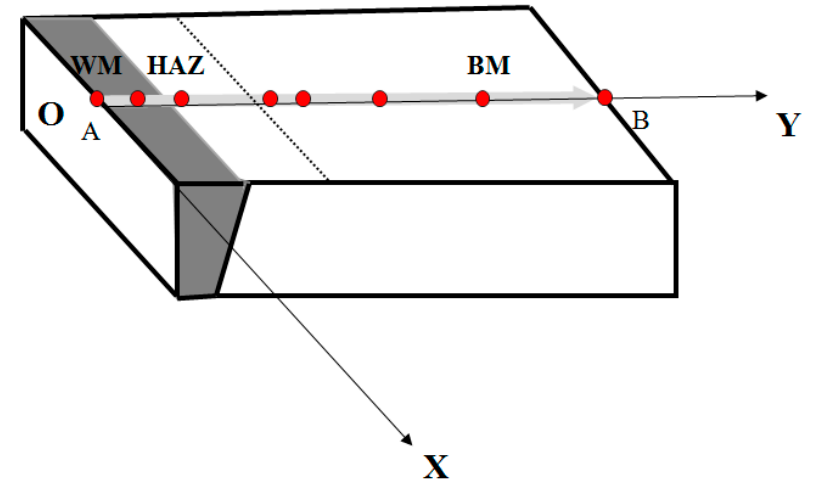
Figure 4. Measuring points of residual stress.